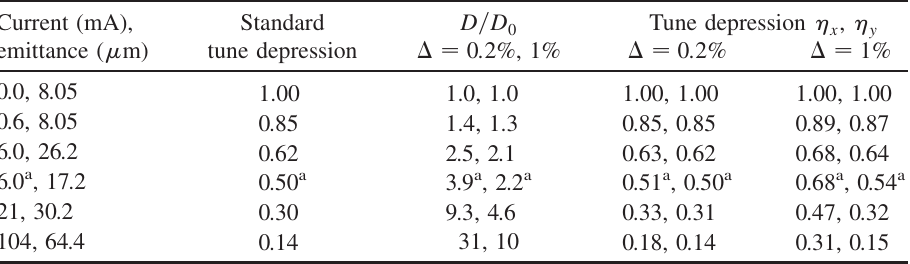
TABLE II. Results of smooth approximation calculations of dispersion, from Eqs. (14a)–(14c), and tune depressions [Eq. (13)]. The operating point is (cid:10) x 0 ¼ (cid:10) y 0 ¼ 6 : 37 , so the zero-current average horizontal dispersion is D 0 ¼ 0 : 045 m . The emittances are 4 (cid:2) rms ,